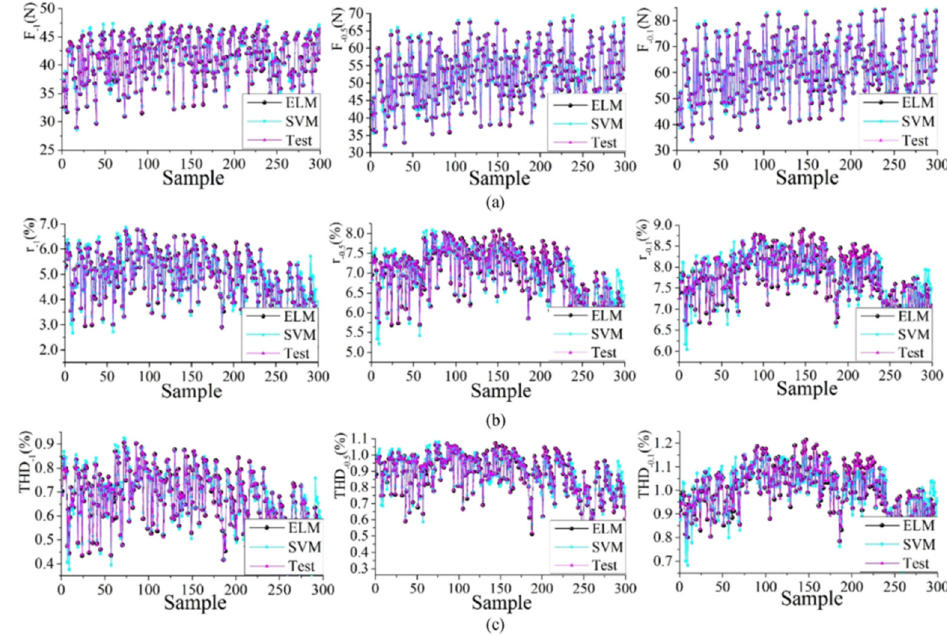
Figure 5. Accuracy test results of ELM: ( a ) Accuracy test of average thrust at different speeds; ( b ) Accuracy test of thrust pulsation at different speeds; ( c ) Accuracy test of THD at different speeds.